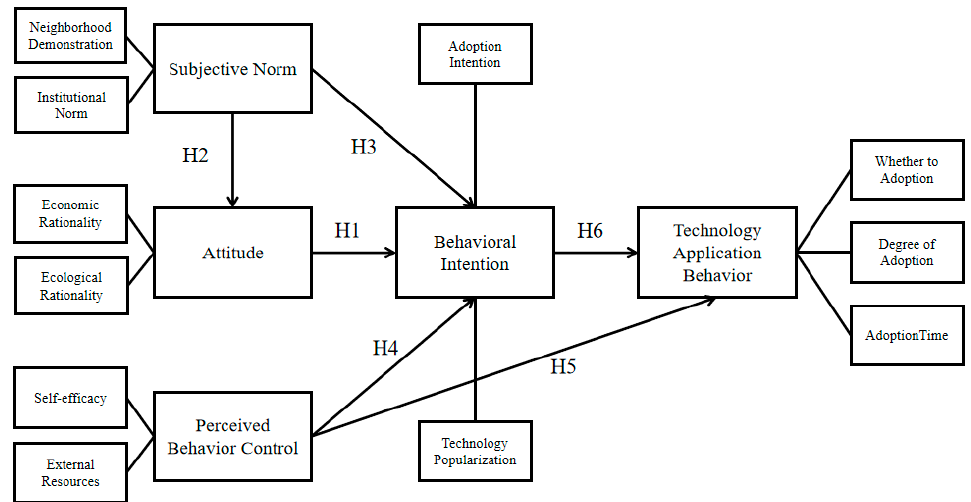
Figure 1. Research Model.